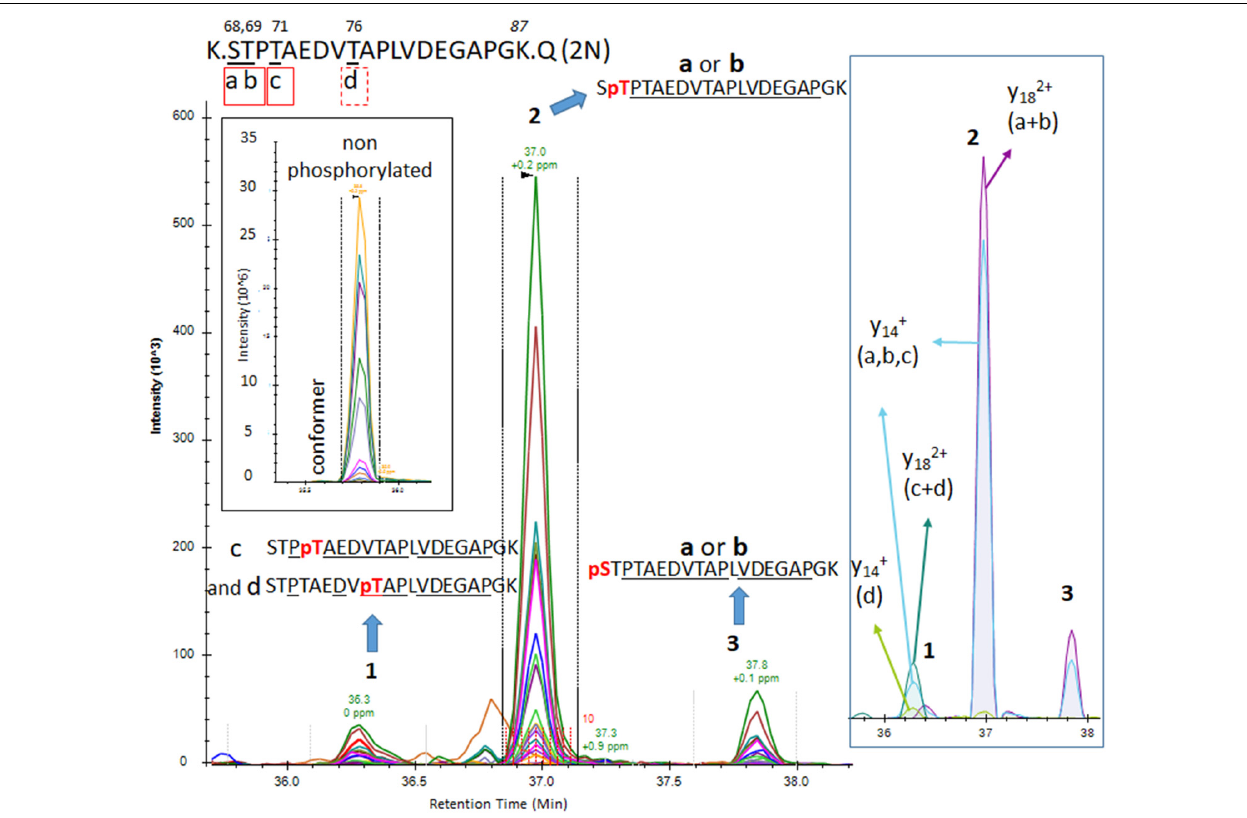
FIGURE 6 | The PRM scan of mono-p-tau sequence 68–87, containing four potential phosphorylation sites. We detected three LC-MS patterns. Patterns 2 and 3 were consistent with phosphorylation at residues S68 (a) or T69 (b). Pattern 1 contained both fragments compatible with the presence of two co-eluted phosphorylated peptides at T71 (c) and T76 (d). Comparison of y14 XIC with and without phosphate in pattern 1 indicates pT71 (c) is more abundant than pT76